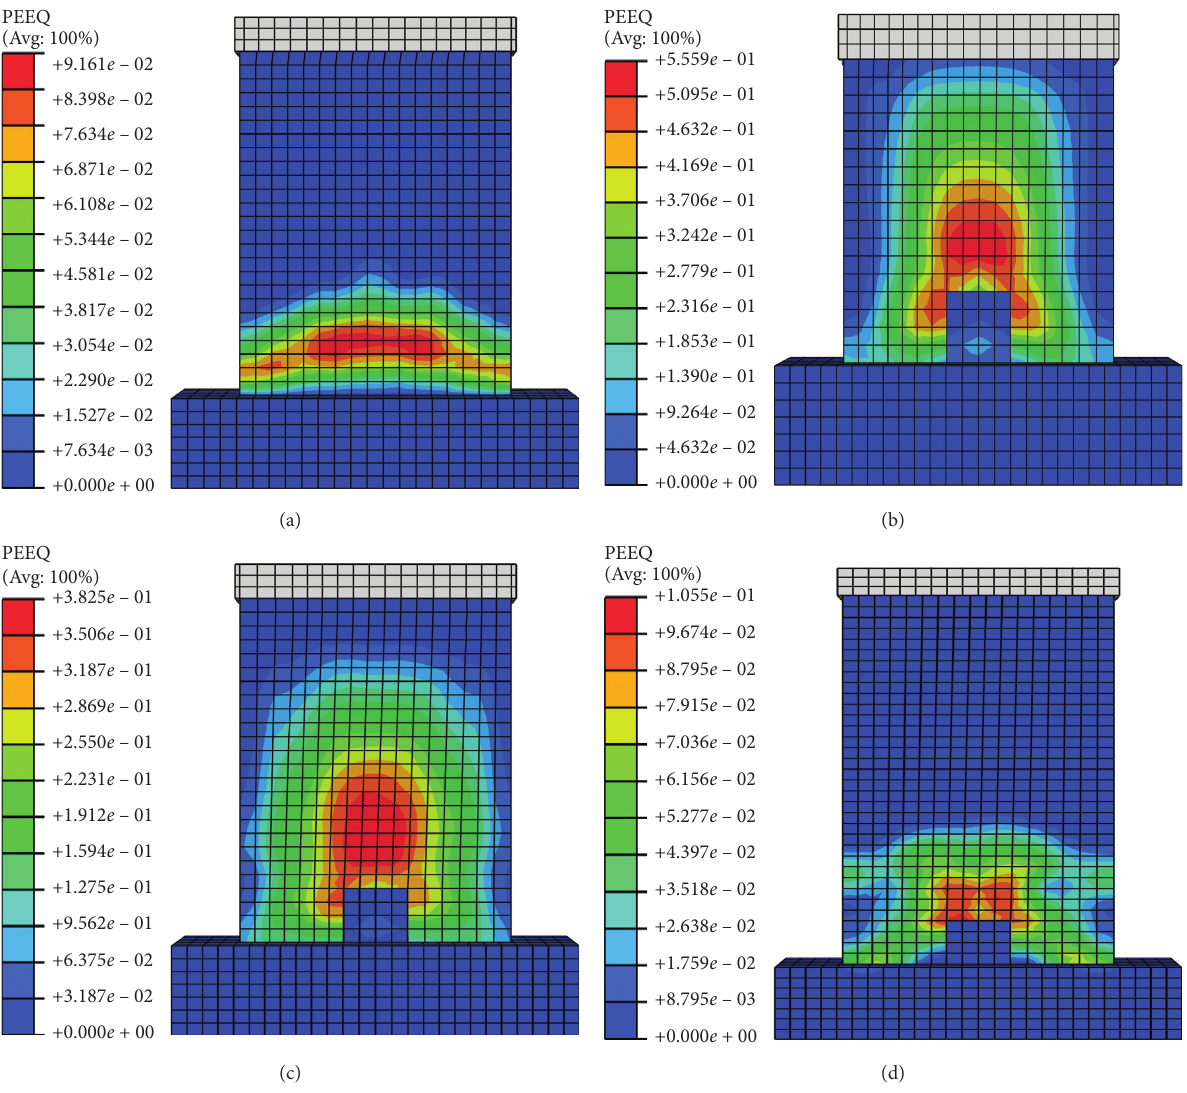
Figure 15: Equivalent plastic strain distribution diagrams of four specimens. (a) SW1. (b) TSW1. (c) TSW2. (d) TSW3. Note: PEEQ, equivalent plastic strain distribution diagram; Avg,